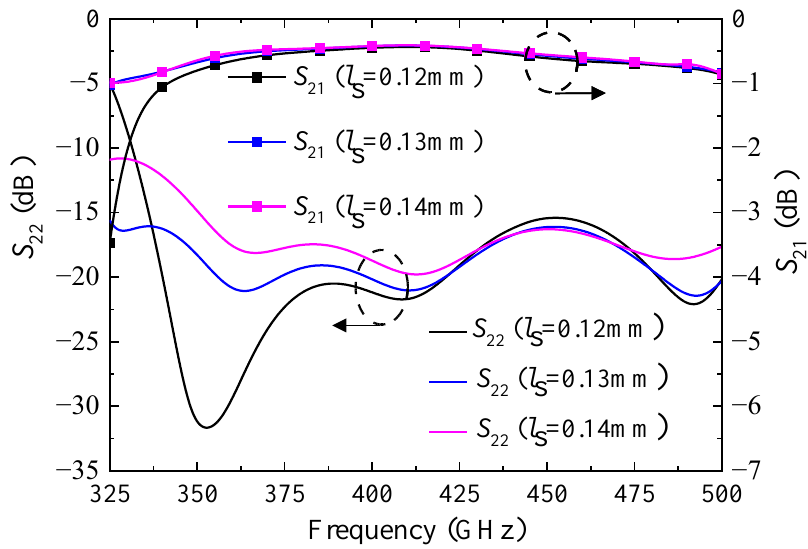
Figure 7. Simulated S -parameters of the proposed transition with different l s (Solid lines represent S 22 ; lines with square symbols represent S 21 ).